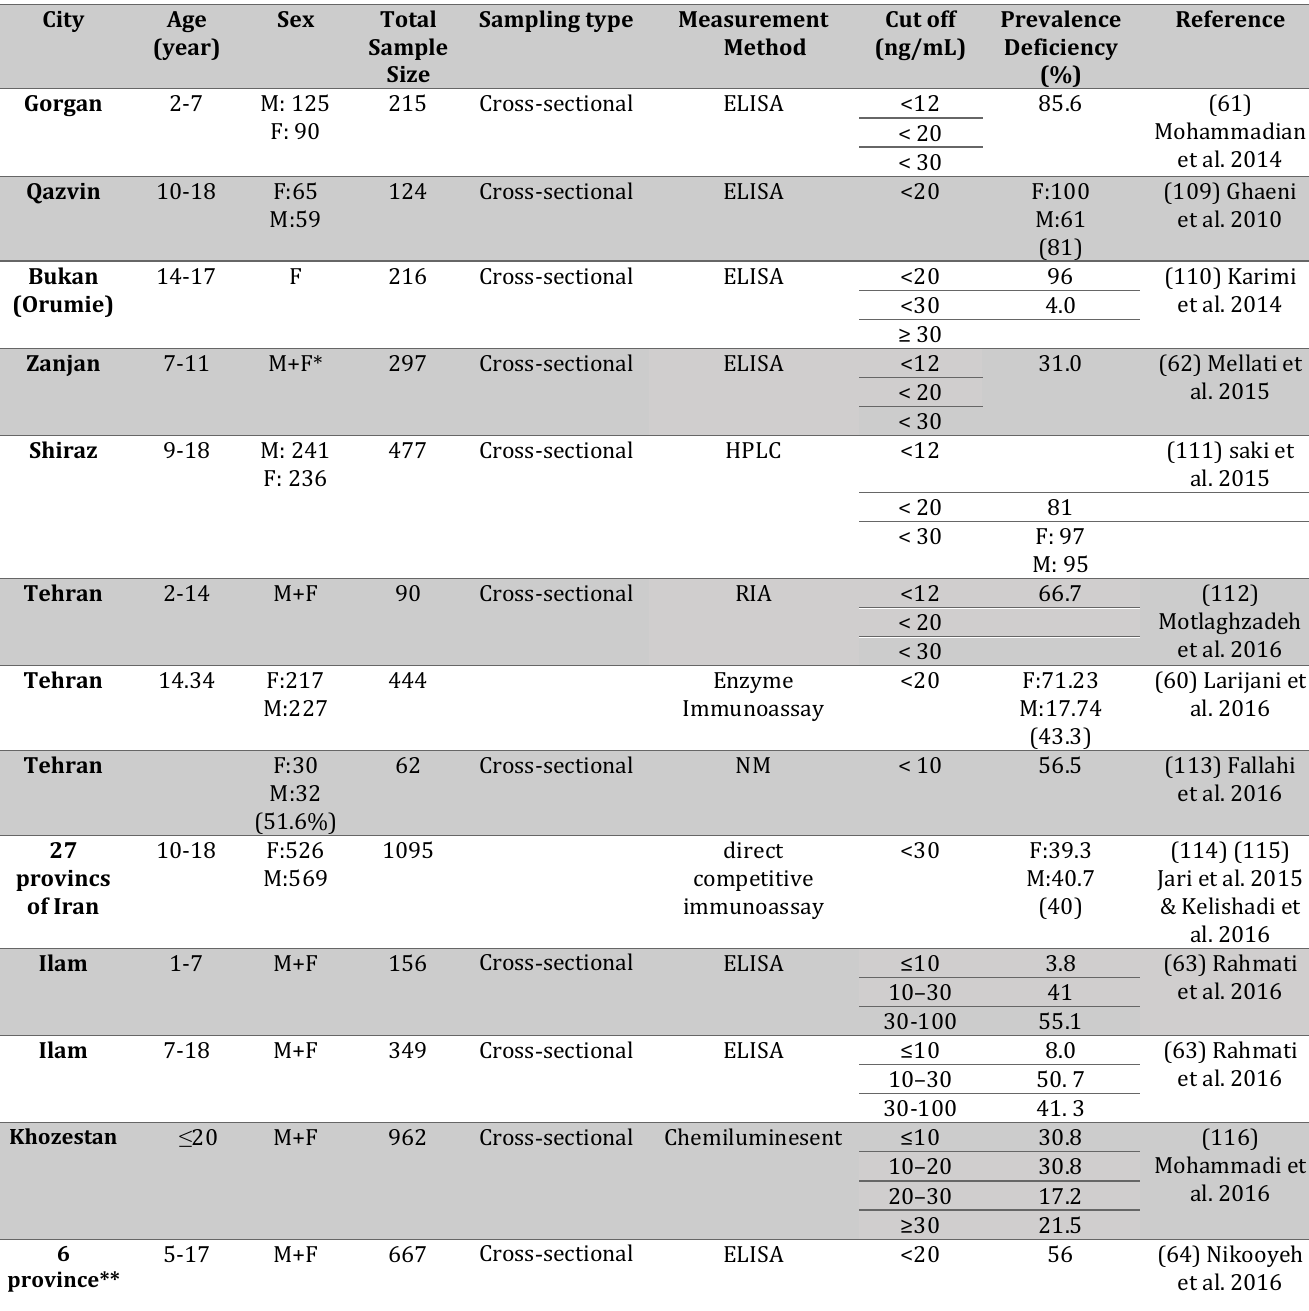
Continue Table 3. Characteristic and main results for the prevalence of vitamin D deficiency or insufficiency in children and adolescents in Iran